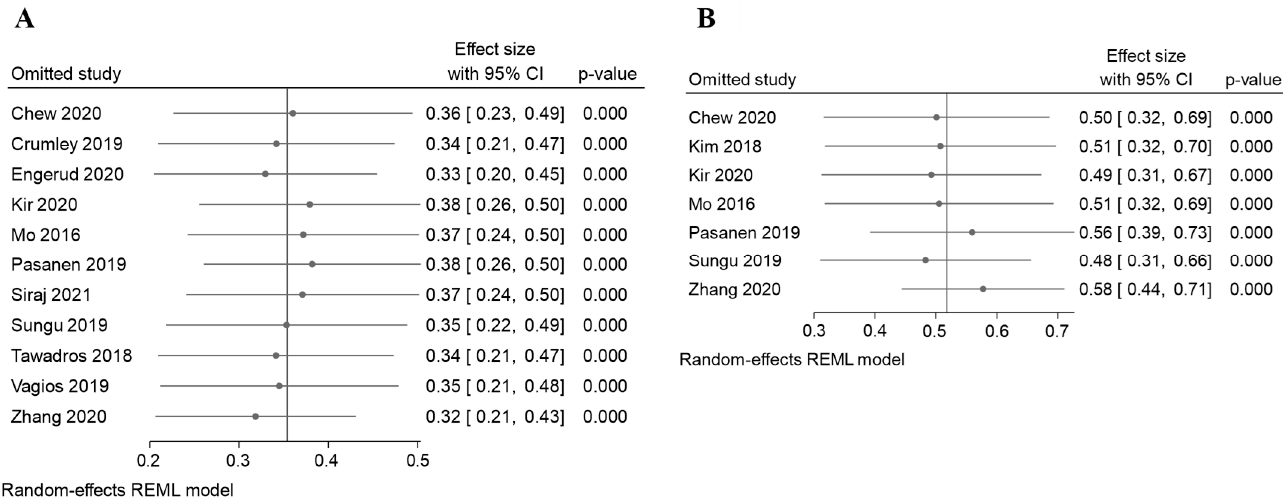
Figure 8. The sensitivity analysis for the results of the meta-analysis [17–19,24–32]. The sensitivity analysis to evaluate the stability of the pooled results for the PD-L1 positive proportion of EC cases in the ( A ) TCs ( B ) ICs. Table 3. The robustness check of the meta-analysis results using the leave-one-out method.